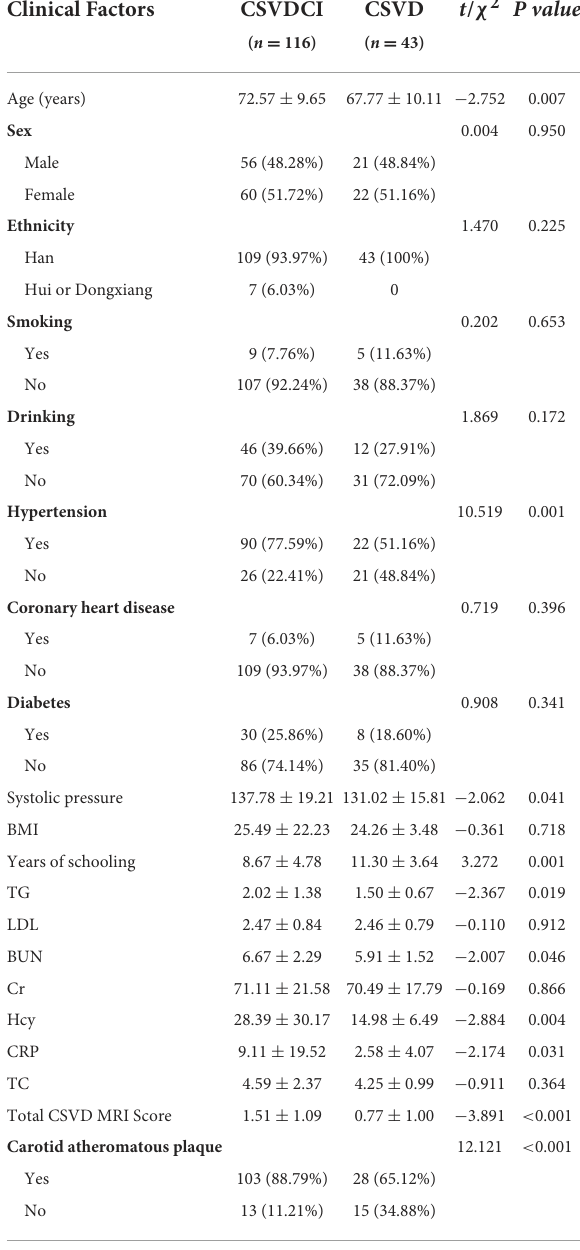
TABLE 2 Clinical baseline data of patients with cerebral small vessel disease. Clinical